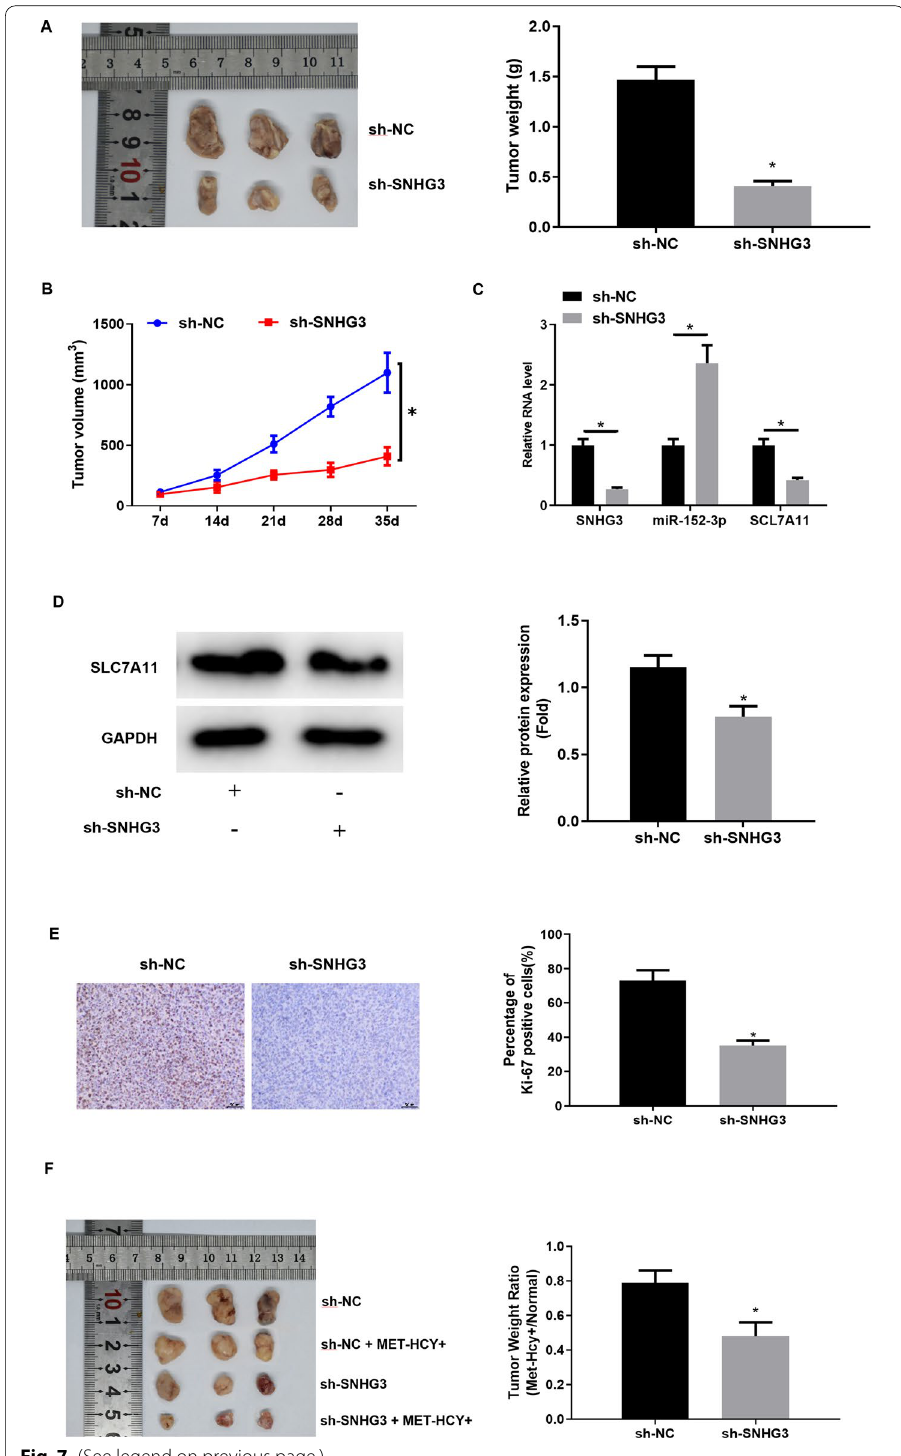
Fig. 7 (See legend on previous